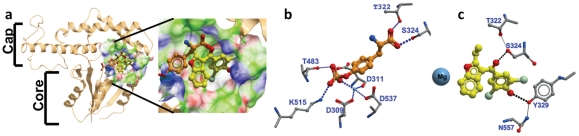
Binding modes of Benzbromarone and the substrate mimic phosphotyrosine differ.(a) In docking experiments phosphotyrosine (gold) and compound 1 (yellow) bind at the interface of the cap and core subdomains of the catalytic ED domain of EYA3. (b) Phosphotyrosine coordinates the active site metal ion and makes hydrogen bonds with residues in all three conserved motifs in the EYAs. (c) Docked conformation (ICM Score −24.8) of compound 1 docked into the active site of EYA3(ED). The conformation shown here was obtained in multiple docking experiments conducted with different starting conformations for the ligand. Compound 1 inserts its dibromo-phenol group into a hydrophobic cavity adjacent to the phosphotyrosine binding site and is anchored by a hydrogen bond with Tyr 329. The carbonyl group forms a hydrogen bond with Ser 324. Compound 1 is not within bonding distance of the metal ion.